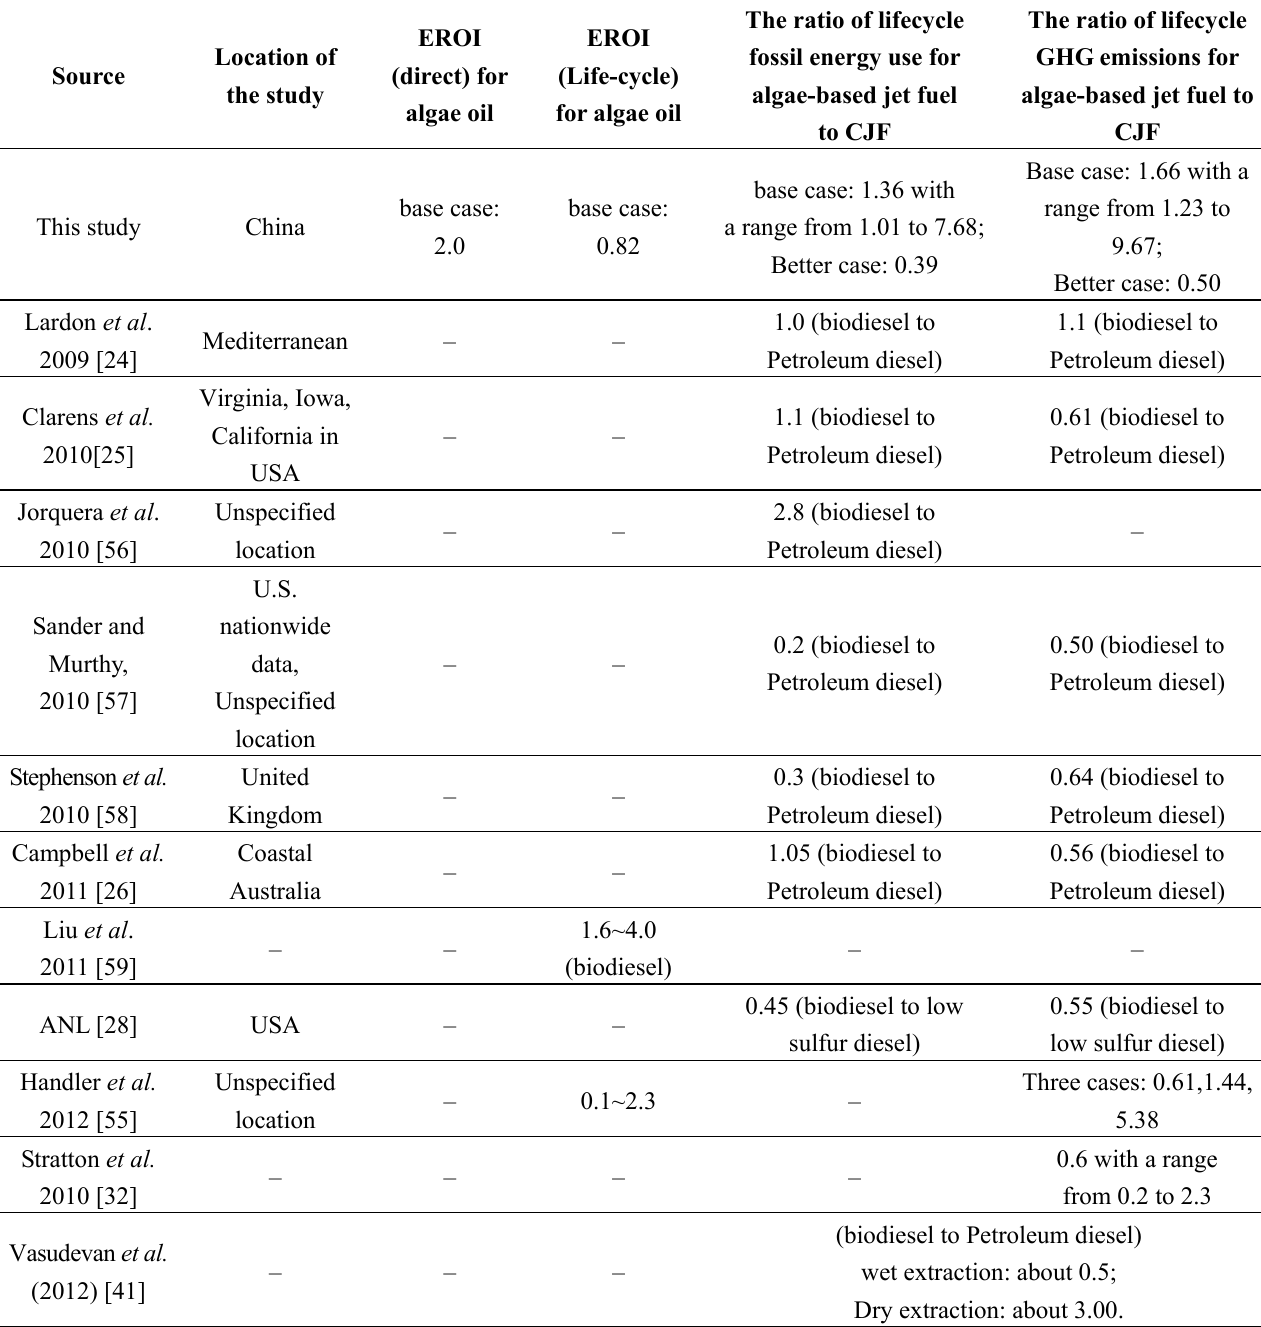
Table 9. Comparisons of results from different LCA studies on open-pond based algal BJF